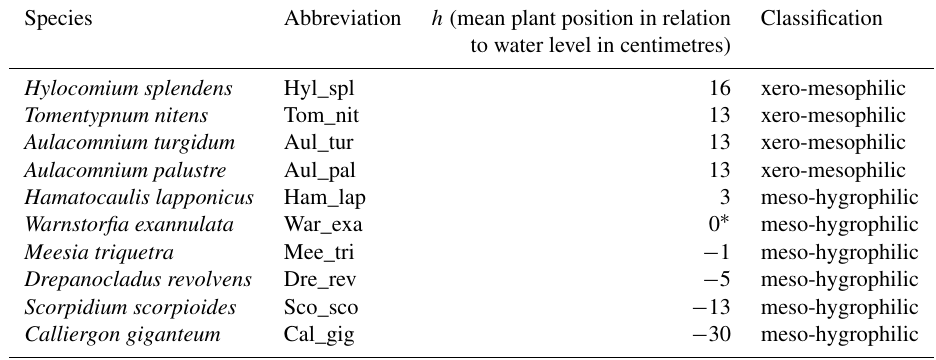
Table 1. Calculated mean plant position relative to the water level and the classification of the sampled brown-moss species. Species Abbreviation h (mean plant position in relation Classification to water level in centimetres) Hylocomium splendens Hyl_spl 16 xero-mesophilic Tomentypnum nitens Tom_nit 13 xero-mesophilic Aulacomnium turgidum Aul_tur 13 xero-mesophilic Aulacomnium palustre Aul_pal 13 xero-mesophilic Hamatocaulis lapponicus Ham_lap 3 meso-hygrophilic Warnstorfia exannulata War_exa 0 ∗ meso-hygrophilic Meesia triquetra Mee_tri − 1 meso-hygrophilic Drepanocladus revolvens Dre_rev − 5 meso-hygrophilic Scorpidium scorpioides Sco_sco − 13 meso-hygrophilic Calliergon giganteum Cal_gig −